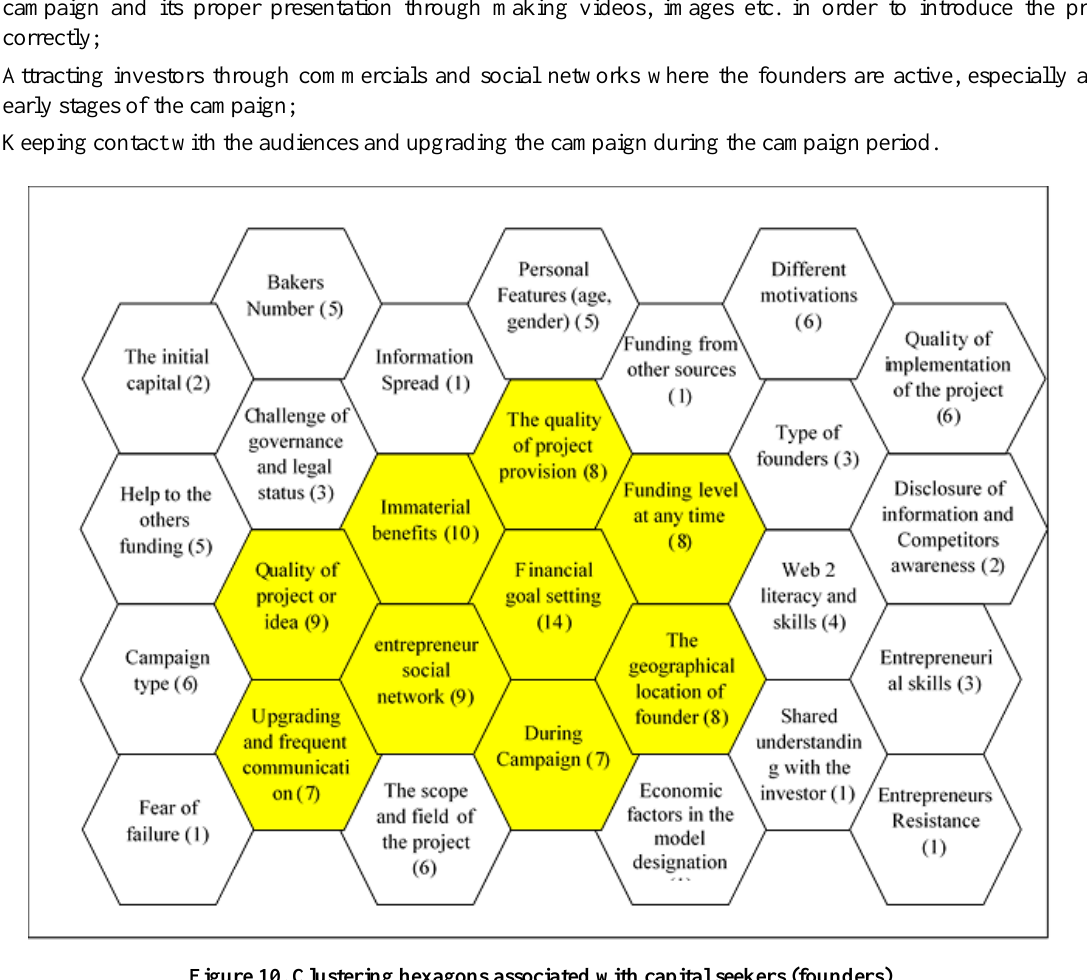
Figure 10. Clustering hexagons associated with capital seekers